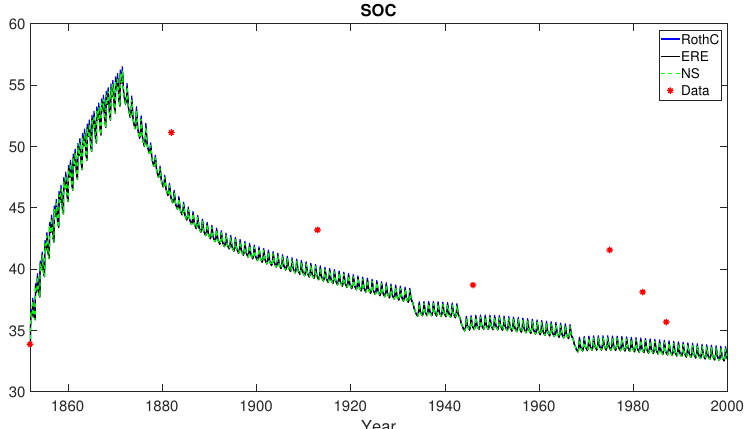
Figure 11. Hoosfield barley experiment. Scenario 3: farmyard manure 1852–1871 and nothing there- after. Organic C in soil data (red bullets) modelled by the RothC (8), ERE (13) and NS (17) methods in the temporal horizon [ 1852, 2000 ] with ∆ t = 1. According to Table 3, RothC approximation shows the best performance with respect to both the statistical indicators RMSE and